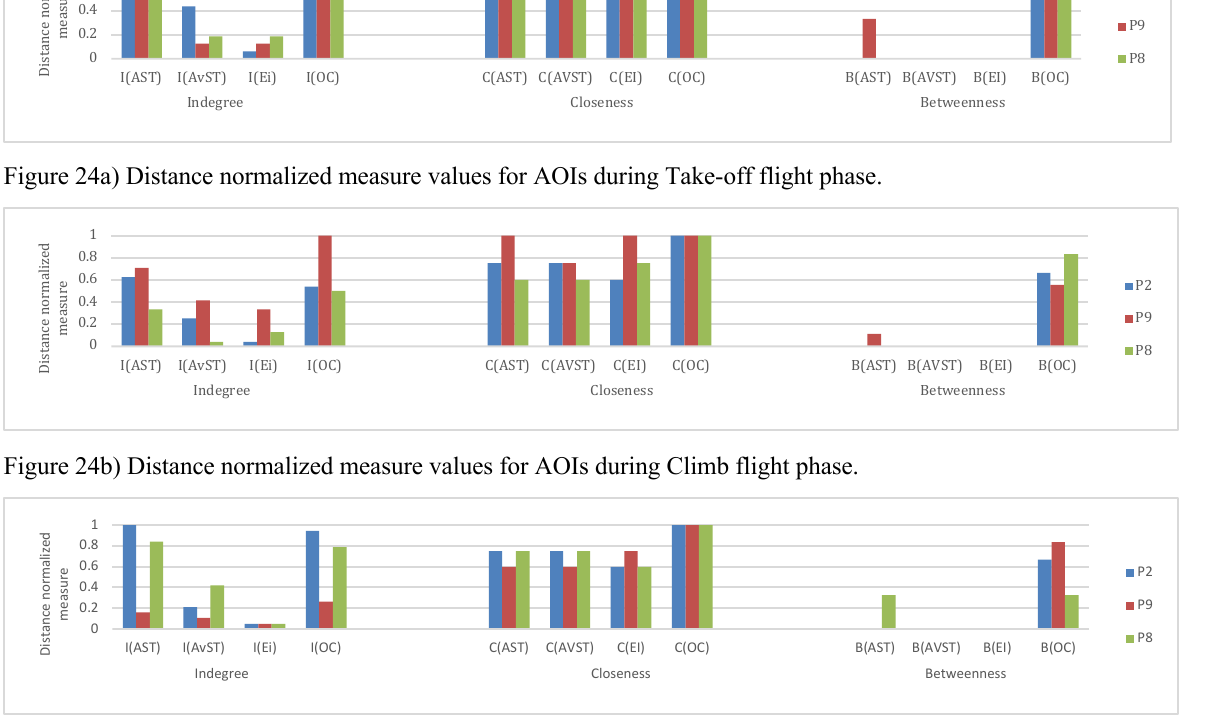
Figure 24c) Distance normalized measure values for AOIs during Straight and Level flight phase.